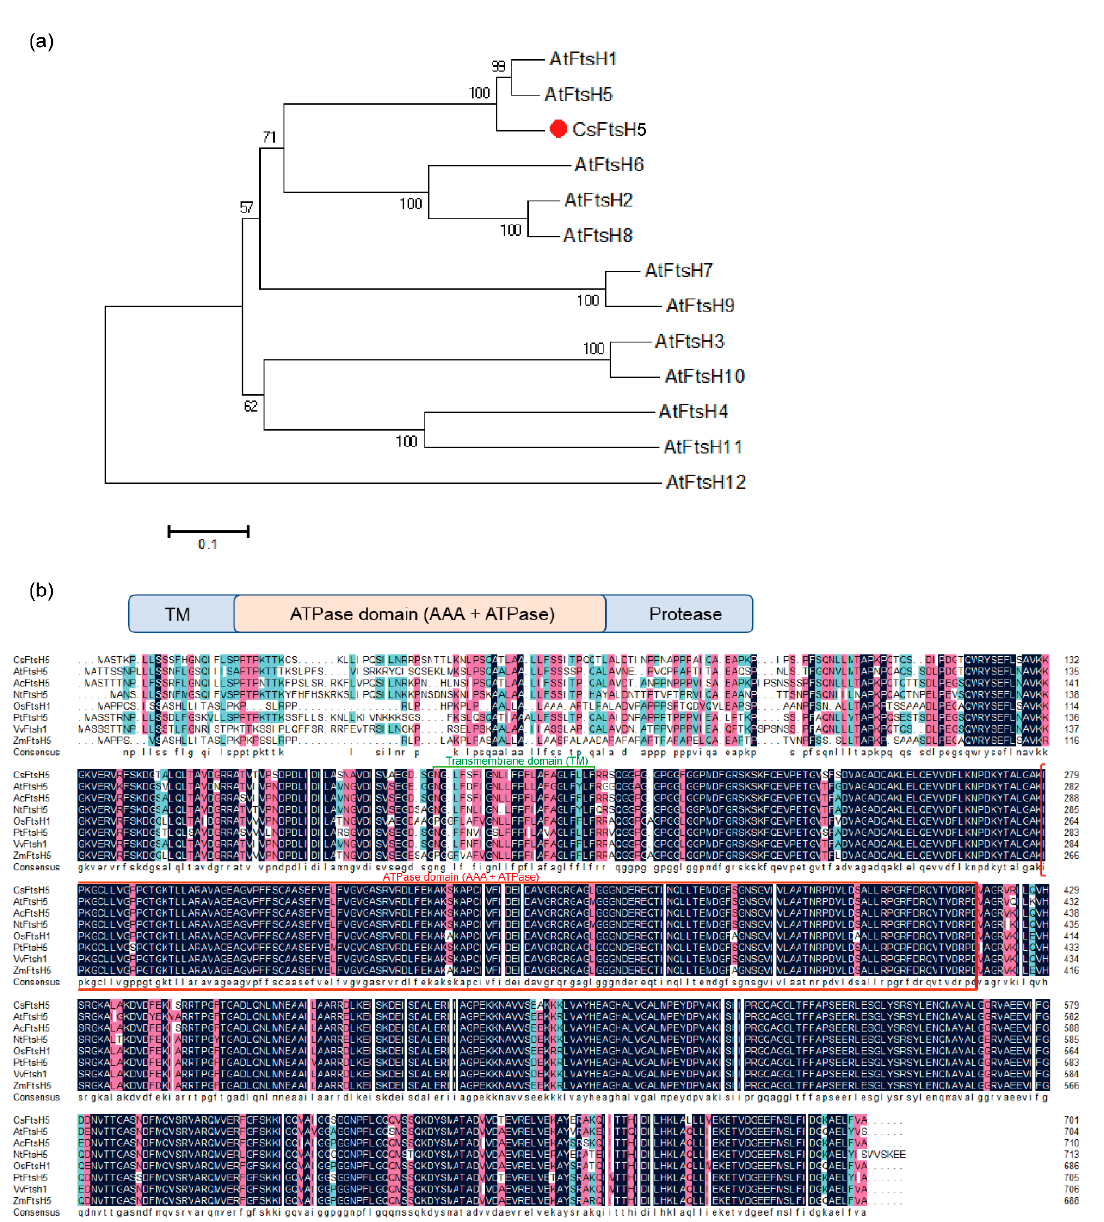
Figure 1. Phylogenetic analyses and protein sequence alignment of CsFtsH5. ( a ) Neighbor-joining phylogenetic tree of CsFtsH5 and AtFtsHs. The red dot indicates CsFtsH5. ( b ) Bioinformatic features of CsFtsH5 domains and multiple sequences alignment of CsFtsH5. At: Arabidopsis thaliana ; Pt: Populus trichocarpa ; Nt: Nicotiana tabacum ; Zm: Zea mays L. ; Vv: Vitis vinifera ; Os: Oryza sativa ; Ac: Actinidia Chinensis